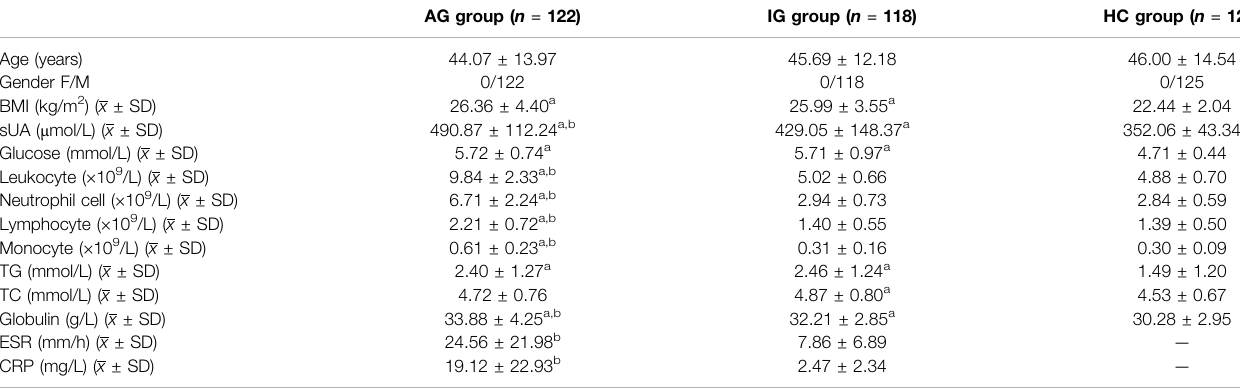
TABLE 2 | Clinical and laboratory data of the